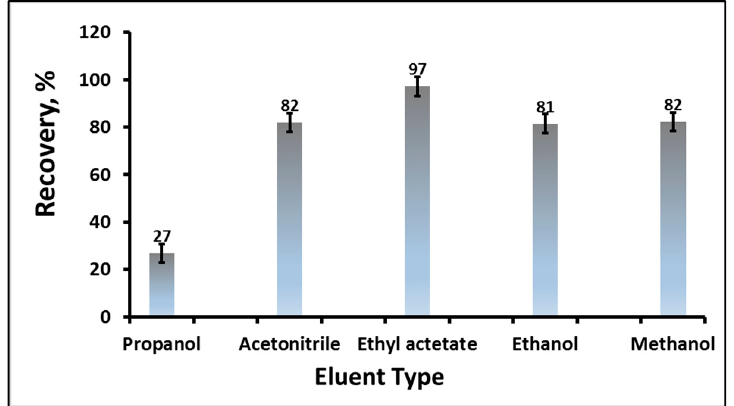
Figure 2. Effect of the eluent type on the desorption of carbaryl from A100 Al-based MOFs ( n = 3).